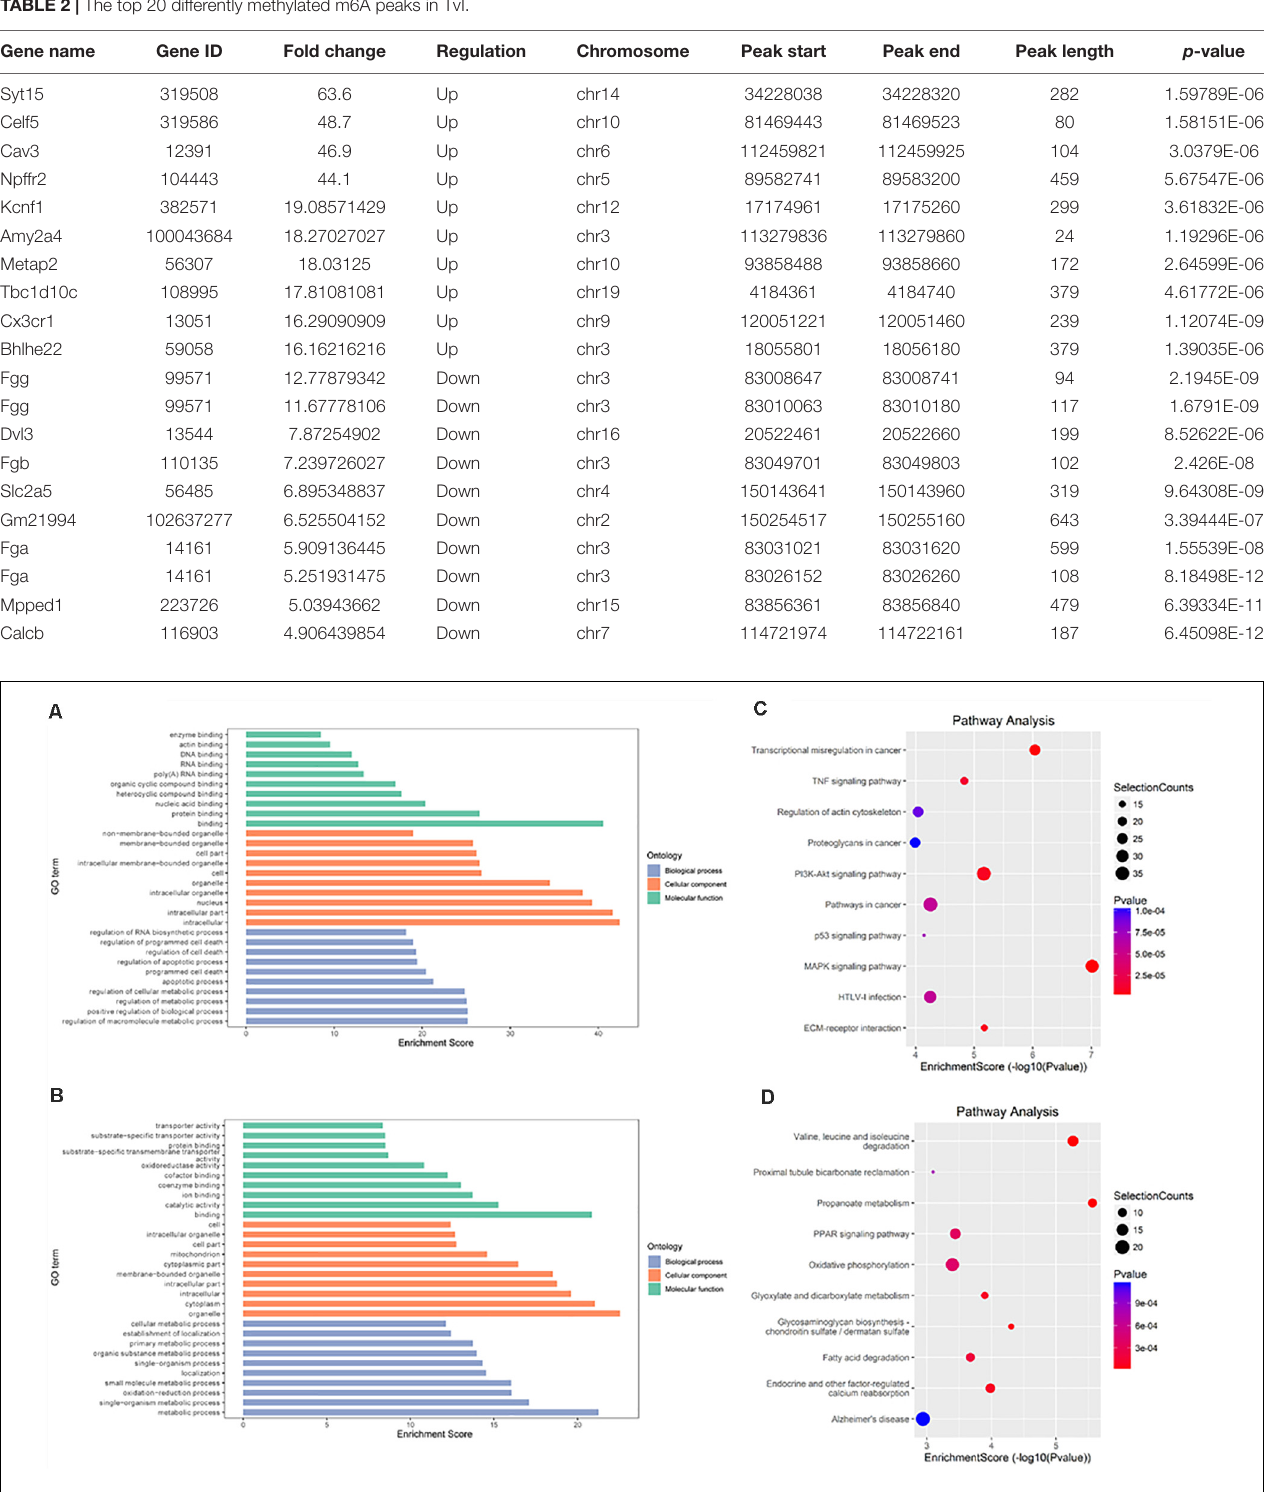
FIGURE 4 | Gene ontology and Kyoto Encyclopedia of Genes and Genomes analyses of coding genes containing DMMSs in IvC. (A) Major gene ontology terms were enriched for the genes containing up-regulated m6A sites in IvC. (B) Major gene ontology terms were enriched for the genes containing down-regulated m6A sites in IvC. (C) Major enriched pathways for the genes containing up-regulated m6A sites in IvC. (D) Major enriched pathways for the genes containing down-regulated m6A sites in IvC.